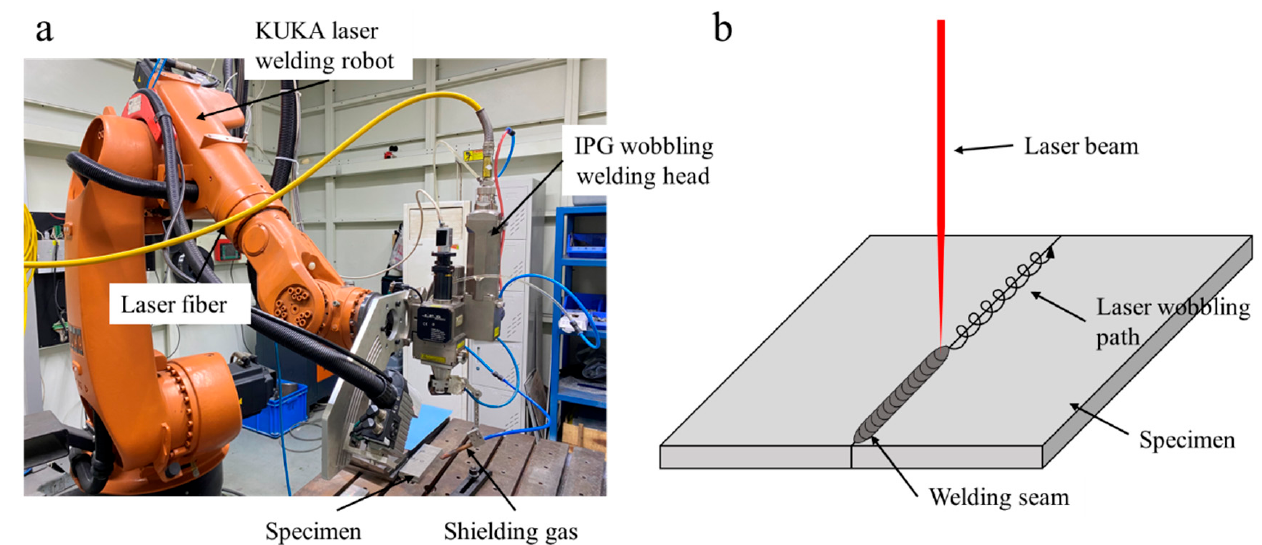
Figure 1. The robot-controlled laser beam welding system with a beam scanning function. ( a ) Actual experimental setup. ( b ) Schematic diagram of the experimental setup.